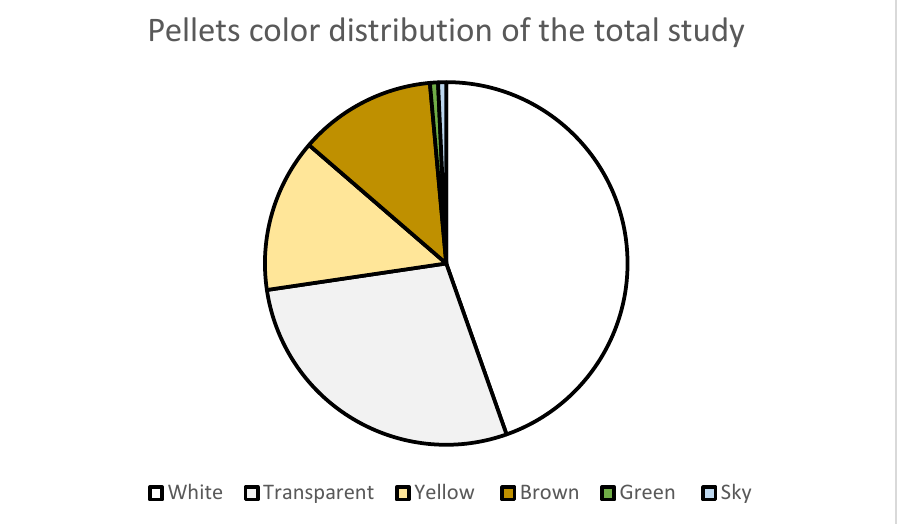
Figure 3. Pellets color distribution of the total study (n =